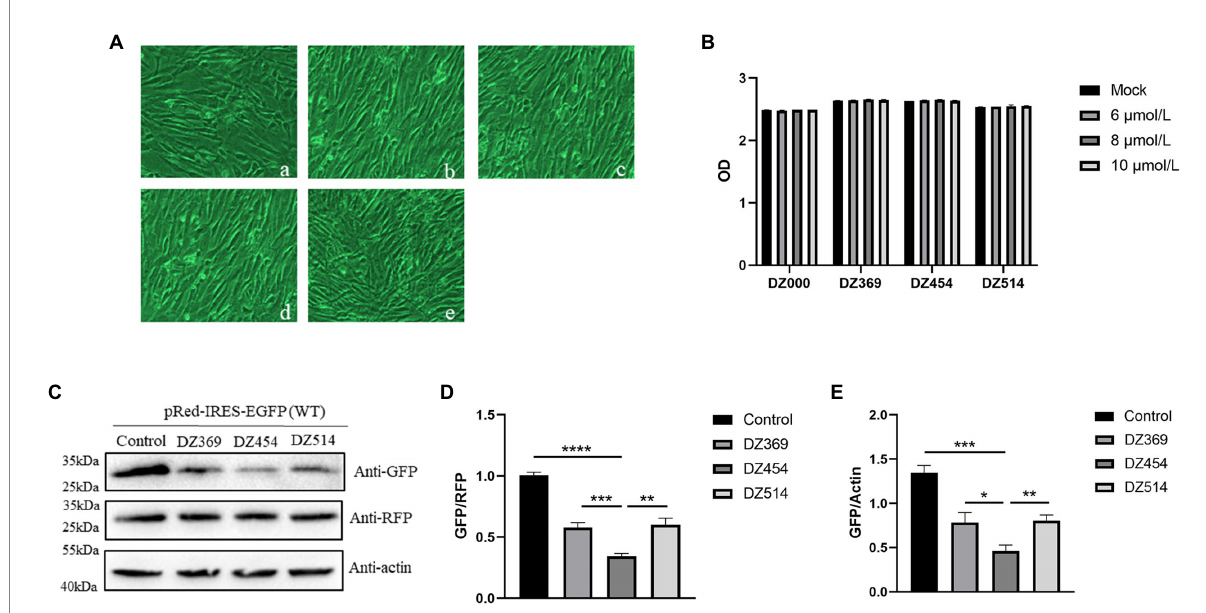
FIGURE 5 DNAzymes inhibit the translation mediated by the 300-618 nt of DHAV-1 5 ′ UTR. (A) Cell morphology was observed 48 h after transfection, (a) Mock; (b) DZ000; (c) DZ369; (d) DZ454; and (e) DZ514. (B) The cell culture supernatant was collected for 48 h after transfection with Dzs, and the absorbance of the samples was measured. (C) pRed-IRES-EGFP was cotransfected with DZ369, DZ454, DZ514 or DZ000 (as the control group) in DEFs, and cells were harvested 48 h later and analyzed by immunoblotting with the indicated antibodies. (D,E) Band intensity was quantified with ImageJ software, and RFP or β -actin was used as the mandatory control or loading control. The ratio of GFP to RFP or GFP to β -actin was normalized to the respective levels in the control group. Differences between two groups were analyzed by Student’s t -test and were considered